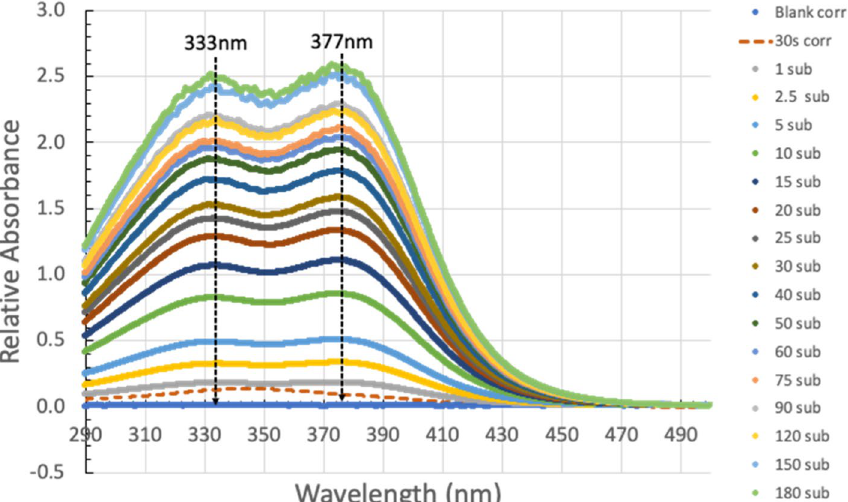
Fig. 3 Baseline-corrected, 30 s subtracted spectra over 1–180 min dissolution for 300 µM fresh Yomesan niclosamide in nominal pH 9.35 Tris Buffer. The 30 s scan is shown as the dashed orange line and this 30 s scan was subtracted from each subsequent scan for 1 – 180 min. Each spectrum is an average of three scans (note: legend is ordered as 180 min to blank; graph is blank to 180